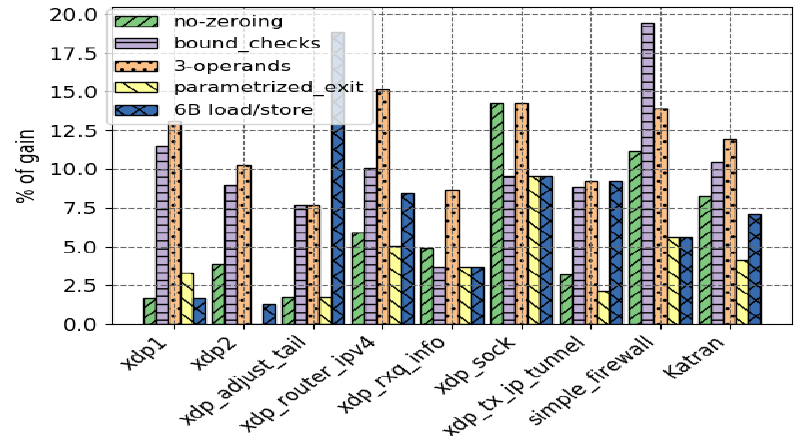
Figure 6. Impact of code optimization eBPF bytecode.